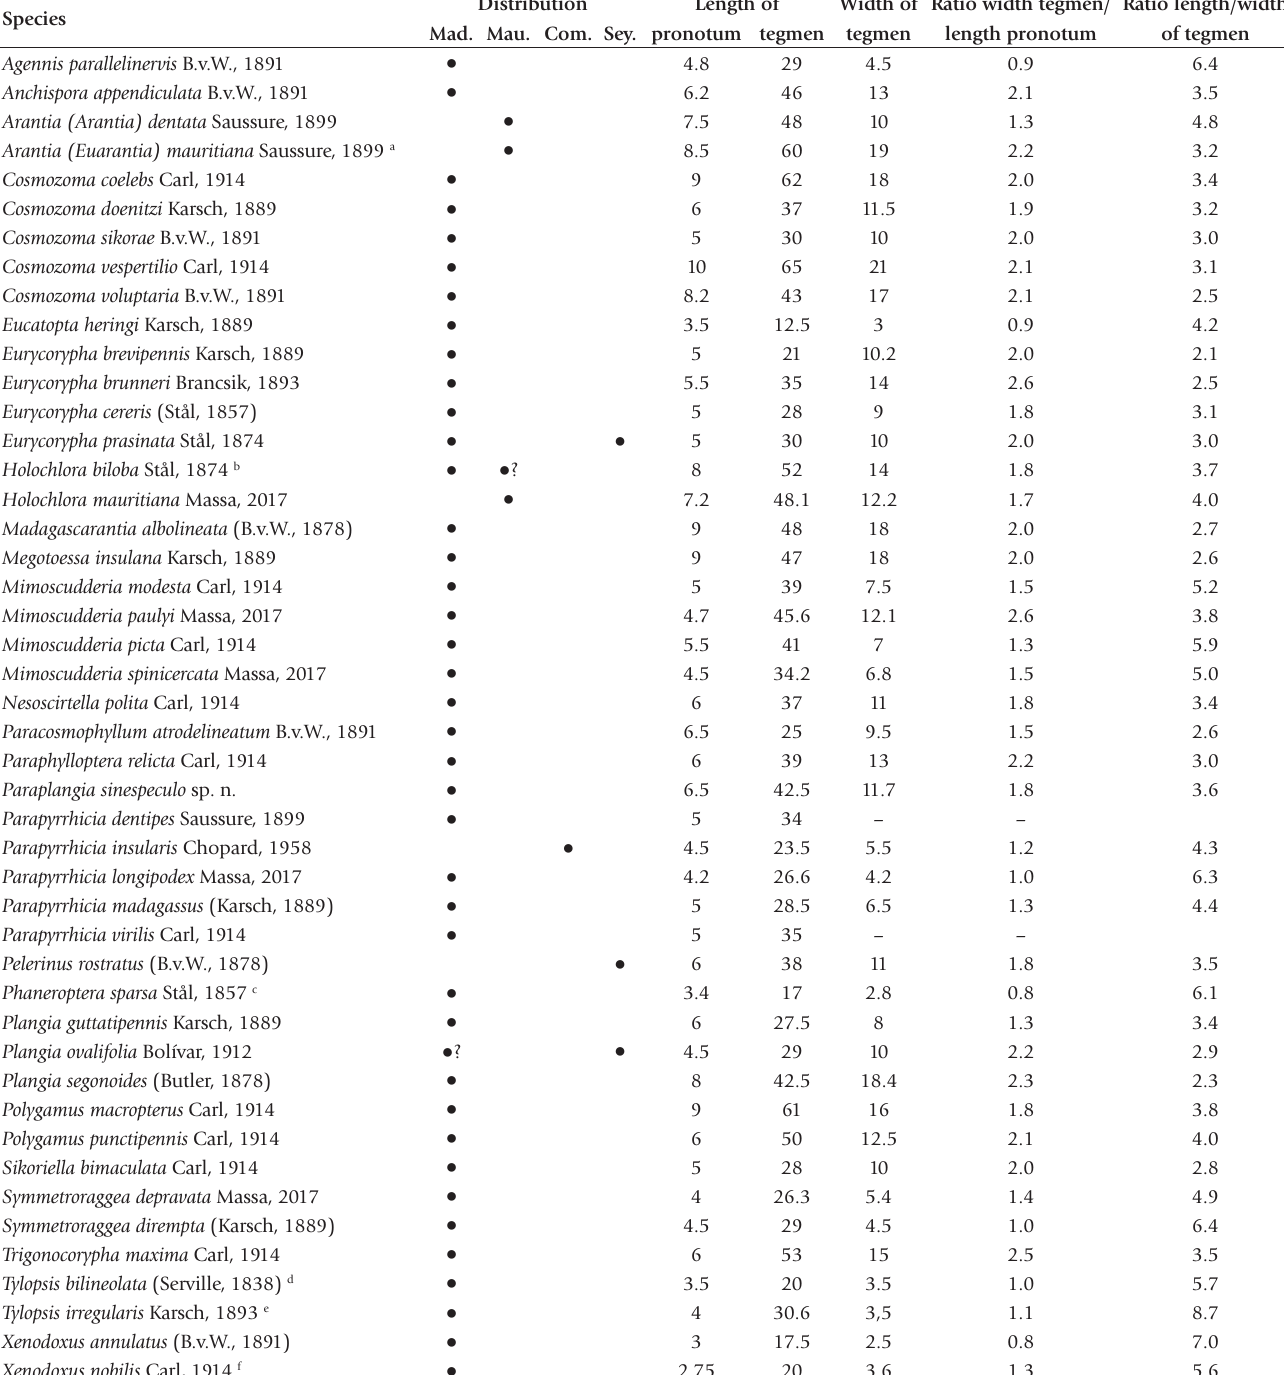
Table 1. List of the known phaneropterine species from Madagascar and some islands in the Western Indian Ocean together with some selected measurements. Abbreviations: Mad = Madagascar, Mau = Mauritius, Com = Comoros, Sey = Seychelles, B.v.W. = Brunner von Wattenwyl. Measurements in mm (taken from original